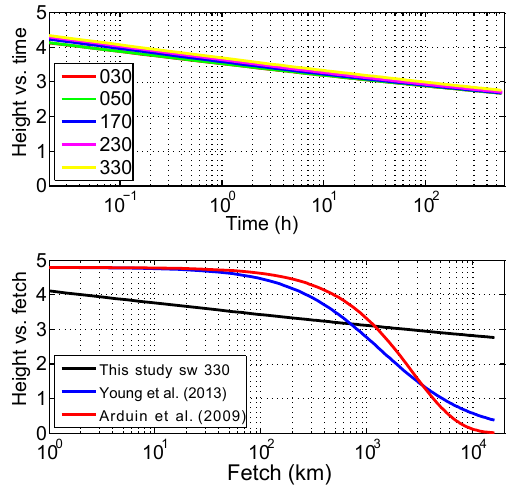
Figure 10. Top – dependence of significant wave height H s on time for the cases of Table 1. Bottom – attenuation of swell for models Ardhuin et al. (2009); Young et al. (2013) and one of this paper (see the legend). Results of duration-limited simulations are recasted into dependencies on fetch by simple transformation (Eq.